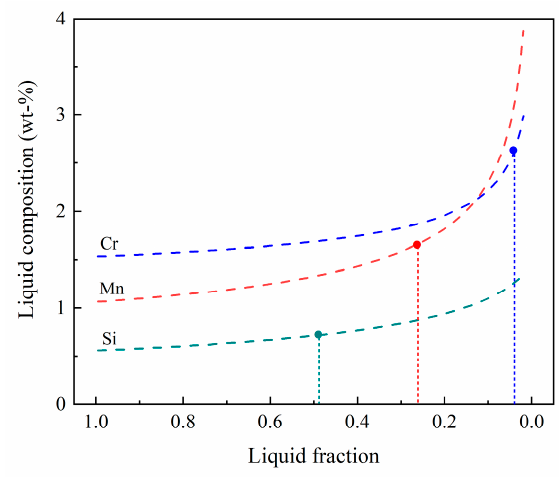
Figure 5. Change of liquid composition during solidification.